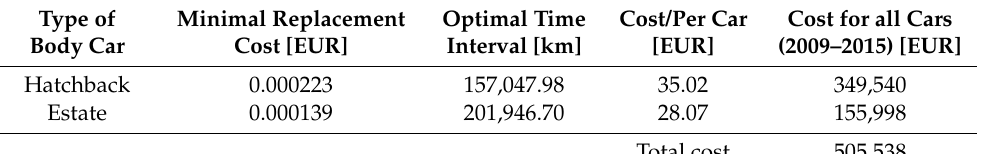
Table 7. Minimal cost